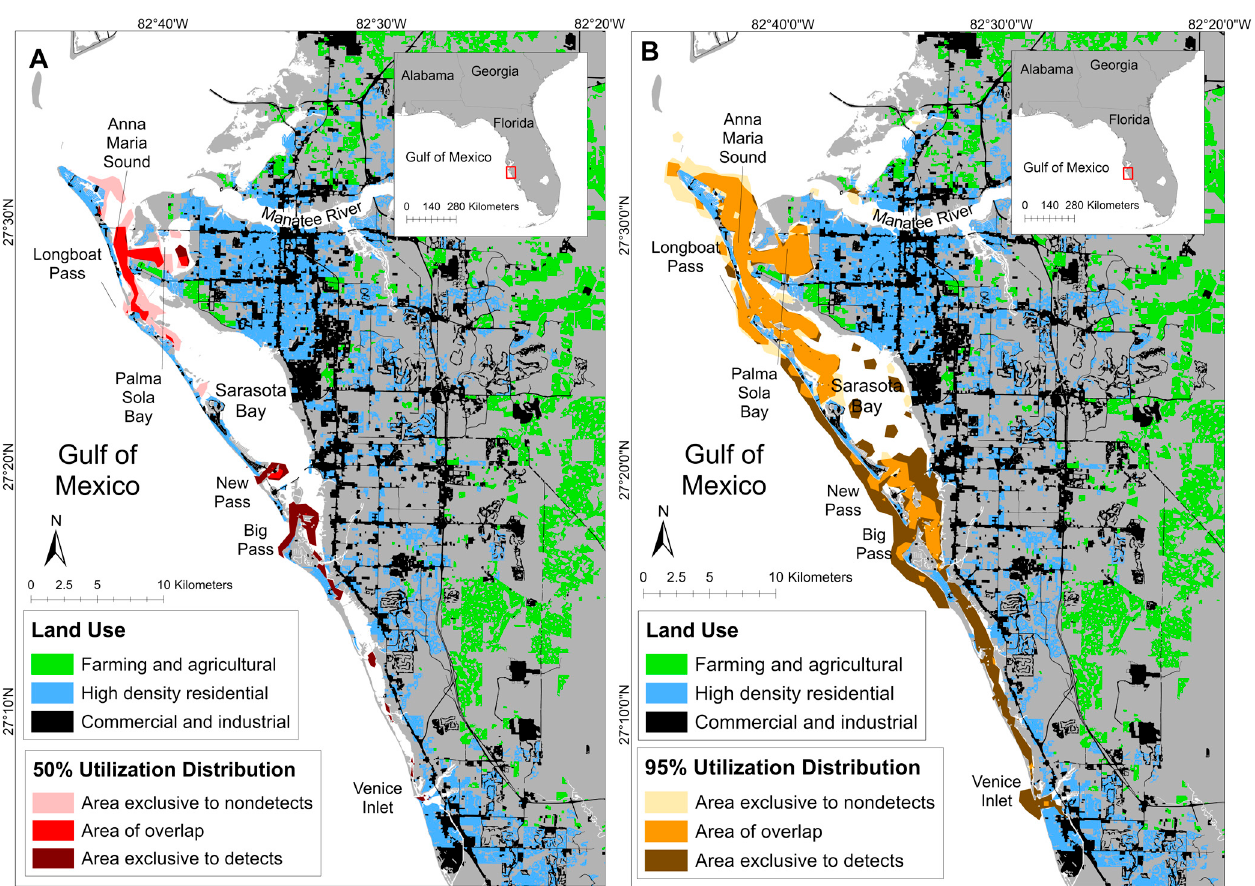
Figure 3. Spatial use of bottlenose dolphins in the Sarasota Bay study area (2010–2019) with detect- able (detects) and nondetectable (nondetects) mono(2-ethylhexyl) phthalate (MEHP) concentra- tions. Photo-identification sighting histories for detect and nondetect individuals were grouped into cumulative ranging patterns with ( A ) core (50% utilization distributions (UDs)) and ( B ) total (95% UDs) areas calculated. Study area indicated by the red box. Land use layer obtained from the Southwest Florida Water Management District geospatial open data portal (2021). Table 3. The 50% and 95% utilization distributions (UDs) and percentage overlap for dolphins in the Sarasota Bay study area with detectable ( n = 30 individuals; n = 2040 sightings) and